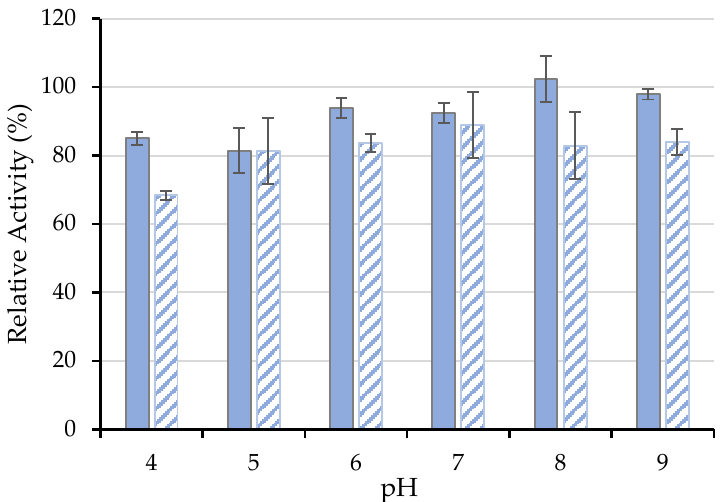
Figure 7. pH effect on the activity of 0.26 mg·mL −1 of ( ■ ) free and ( ) immobilized ASNase onto CX-4 (pH 6.7, 49 min of contact time) for an incubation time of 120 min. Error bars represent the standard deviation.